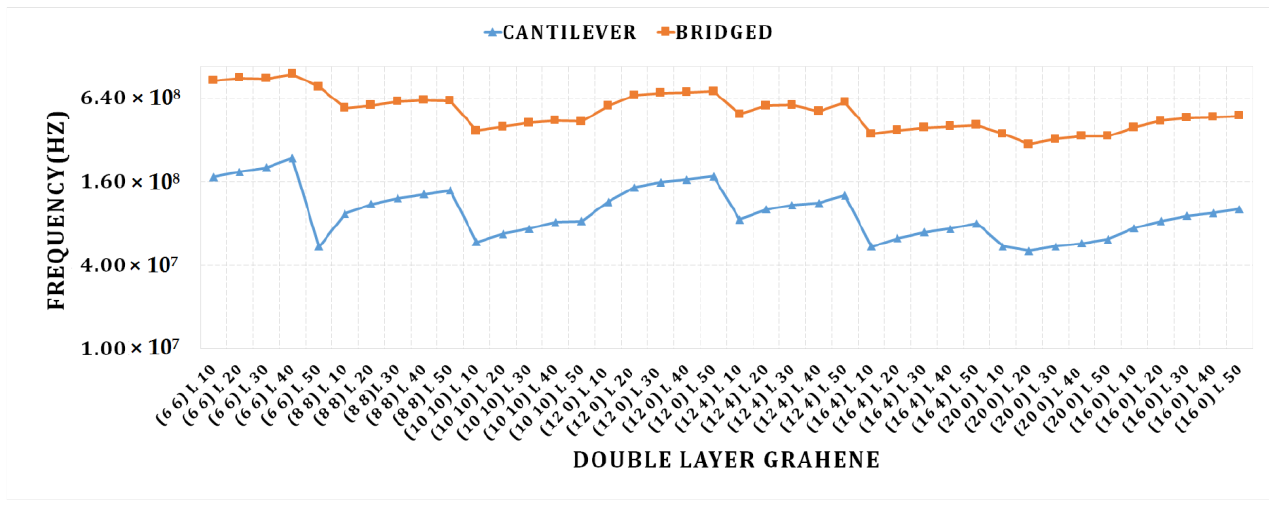
Figure 6. Cantilever and bridged DLGs; graph for different length and chirality vs. frequency.